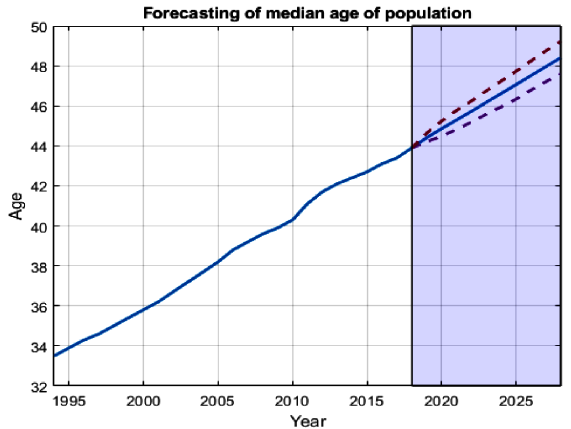
Figure 5. History and forecasting of the population median age (source: authors’